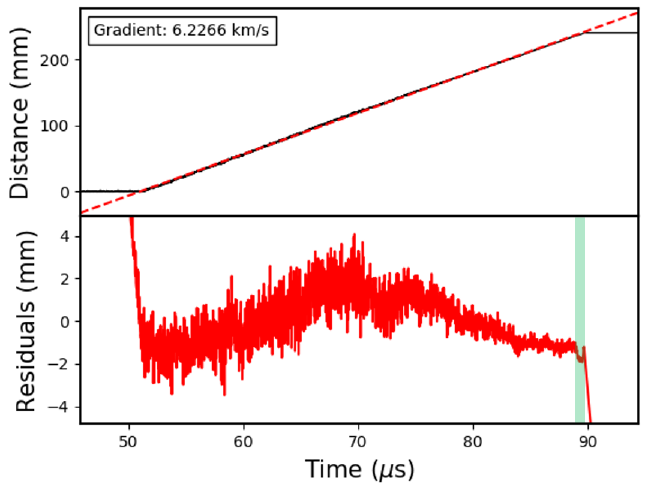
Table 3. The properties of the non-linear region for a 24 cm, 20 nm bandwidth, 37% reflectivity CFBG test. Fluctuation over Relative Length of Average Velocity Highlighted Region Highlighted Region (km/s) (%) (%) 0.26 ± 0.04 1.60 ± 0.12